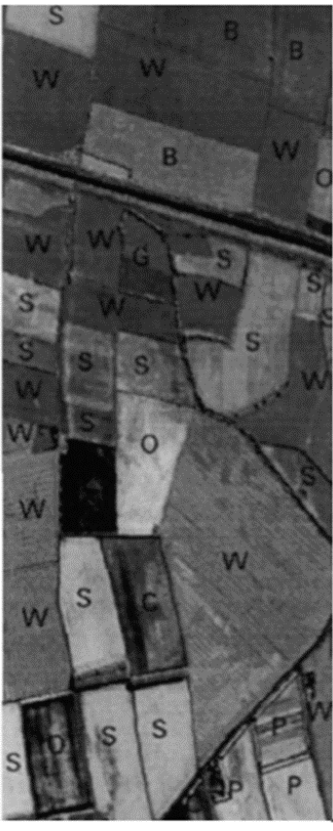
Figure 2. Extract of the ATM data, in 0.60–0.63 μ m waveband, with class type annotated.